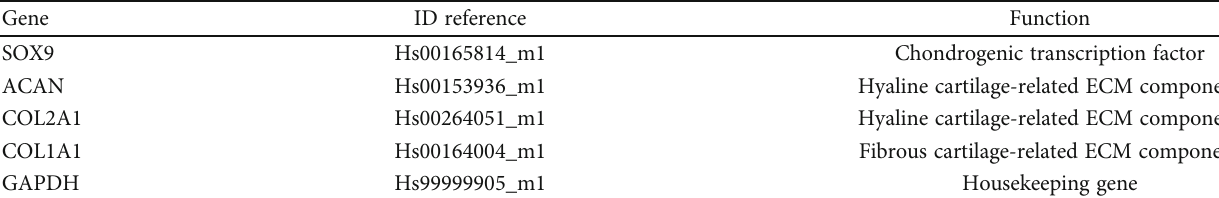
Table 1: Gene marker primers.